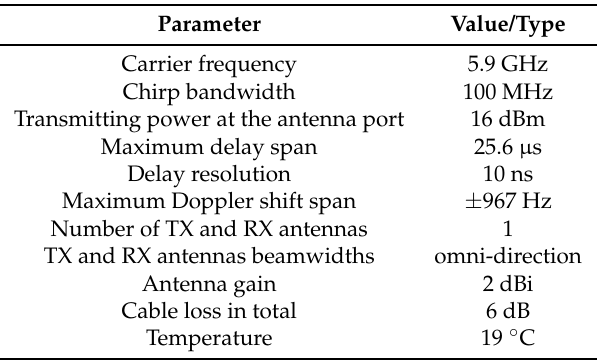
Table 1. The measurement